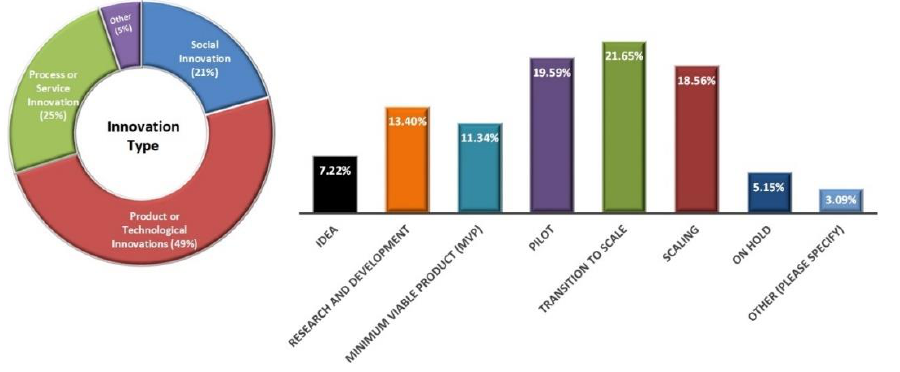
Figure 2. Survey responses as innovation descriptions and development stages.